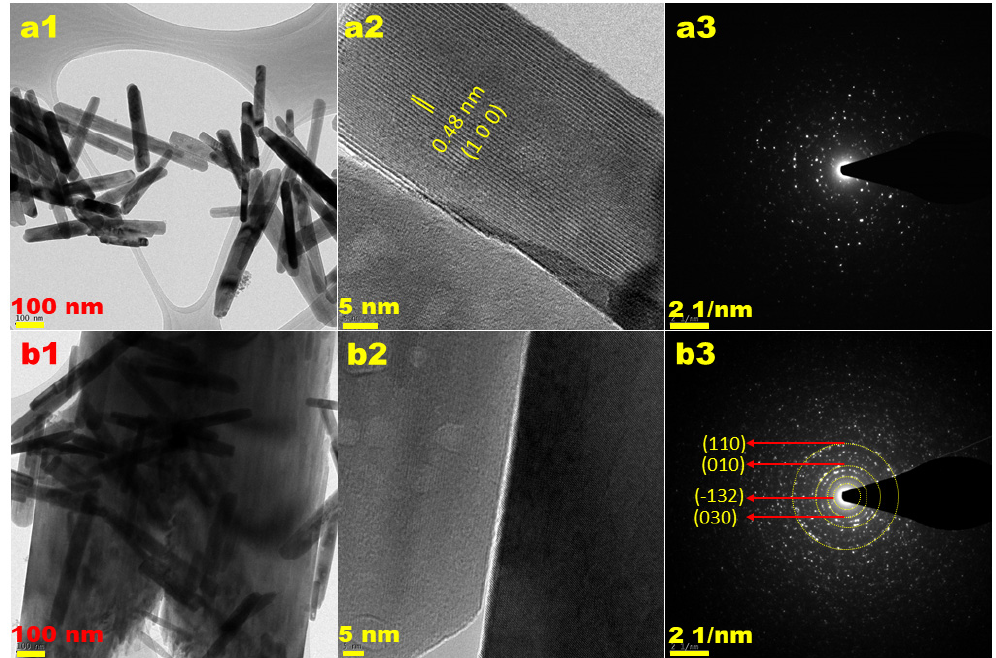
Figure 5. TEM analysis of electrocatalysts, low resolution MW-12 ( a1 ), MW@GO-12 ( b1 ), high resolution MW-12 ( a2 ) MW@GO-12 ( b2 ) and the corresponding SAED pattern MW-12 ( a3 ), MW@GO- 12 ( b3 ).